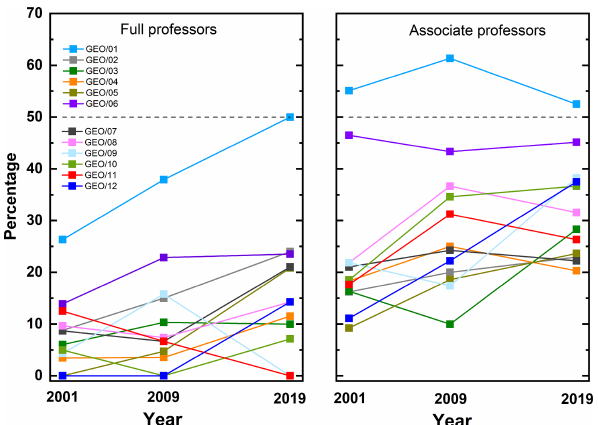
Figure 4. Percentages of female full and associate professors in all GEO scientific areas (from GEO/01 to GEO/12) of the Italian university system relative to 2001–2019 time span (data source: MIUR, https://cercauniversita.cineca.it/php5/docenti/cerca. php, last access: 31 October